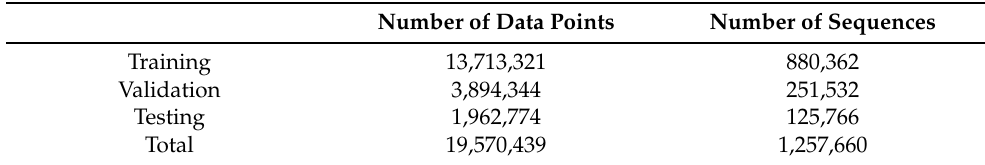
Table 2. The number of data points (evolution of a structure from one time step to the next one) and number of sequences (total structure lifetime) in the dataset and in each one of the three sets it has been divided into.